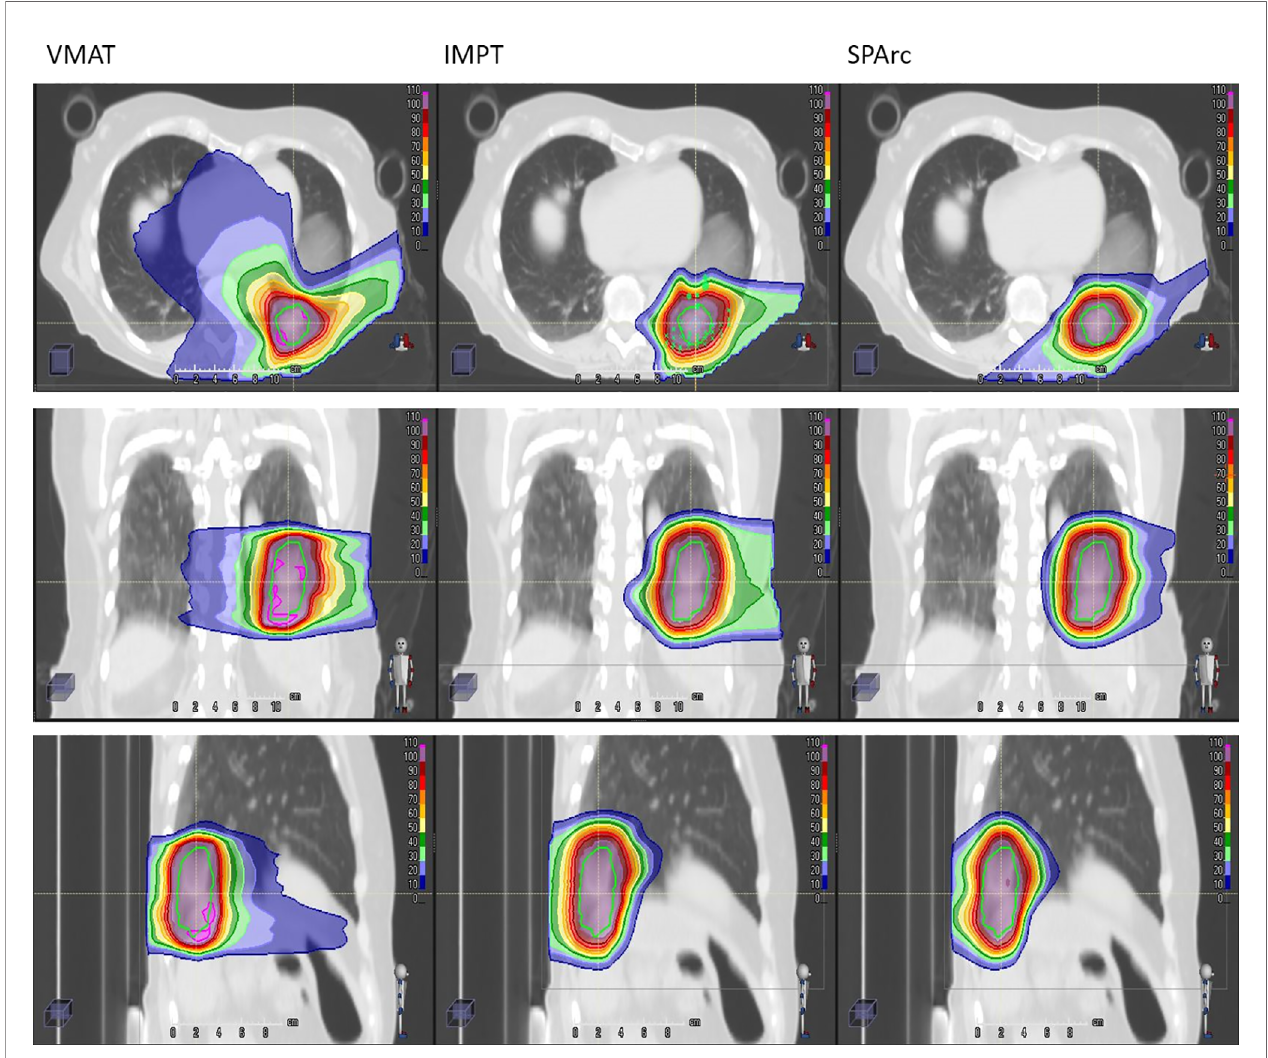
FIGURE 3 | Isodose distributions of patient #10 for treatment plan using VMAT ( fi rst column), IMPT (the second column), and SPArc (the third column). The green contour represents ITV. 100% dose is equal to prescription dose.